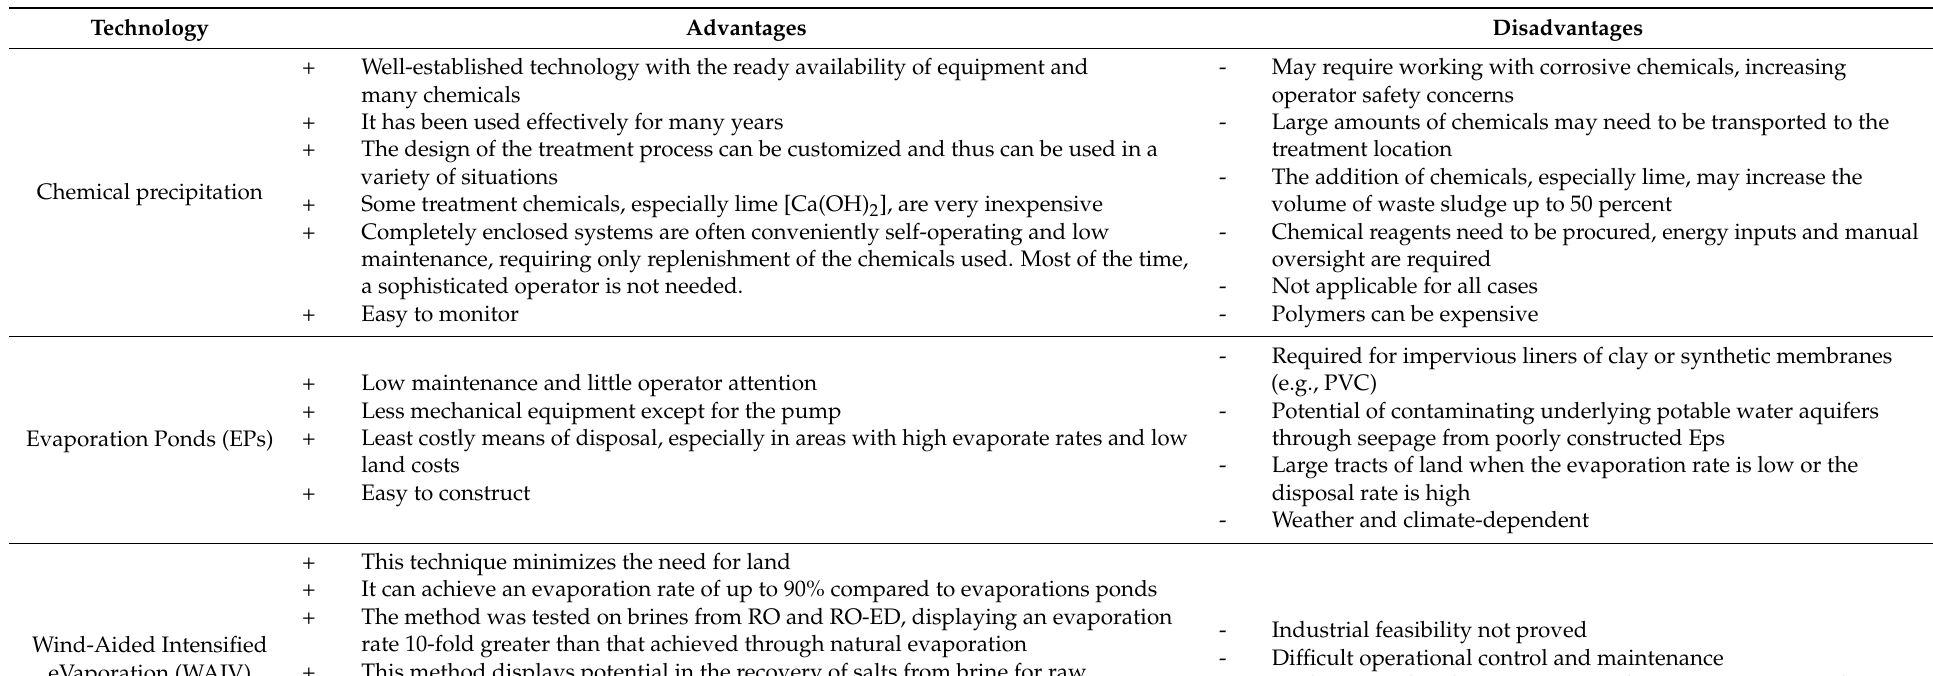
Table 8. Advantages and disadvantages of state-of-the-art technologies for saline wastewater